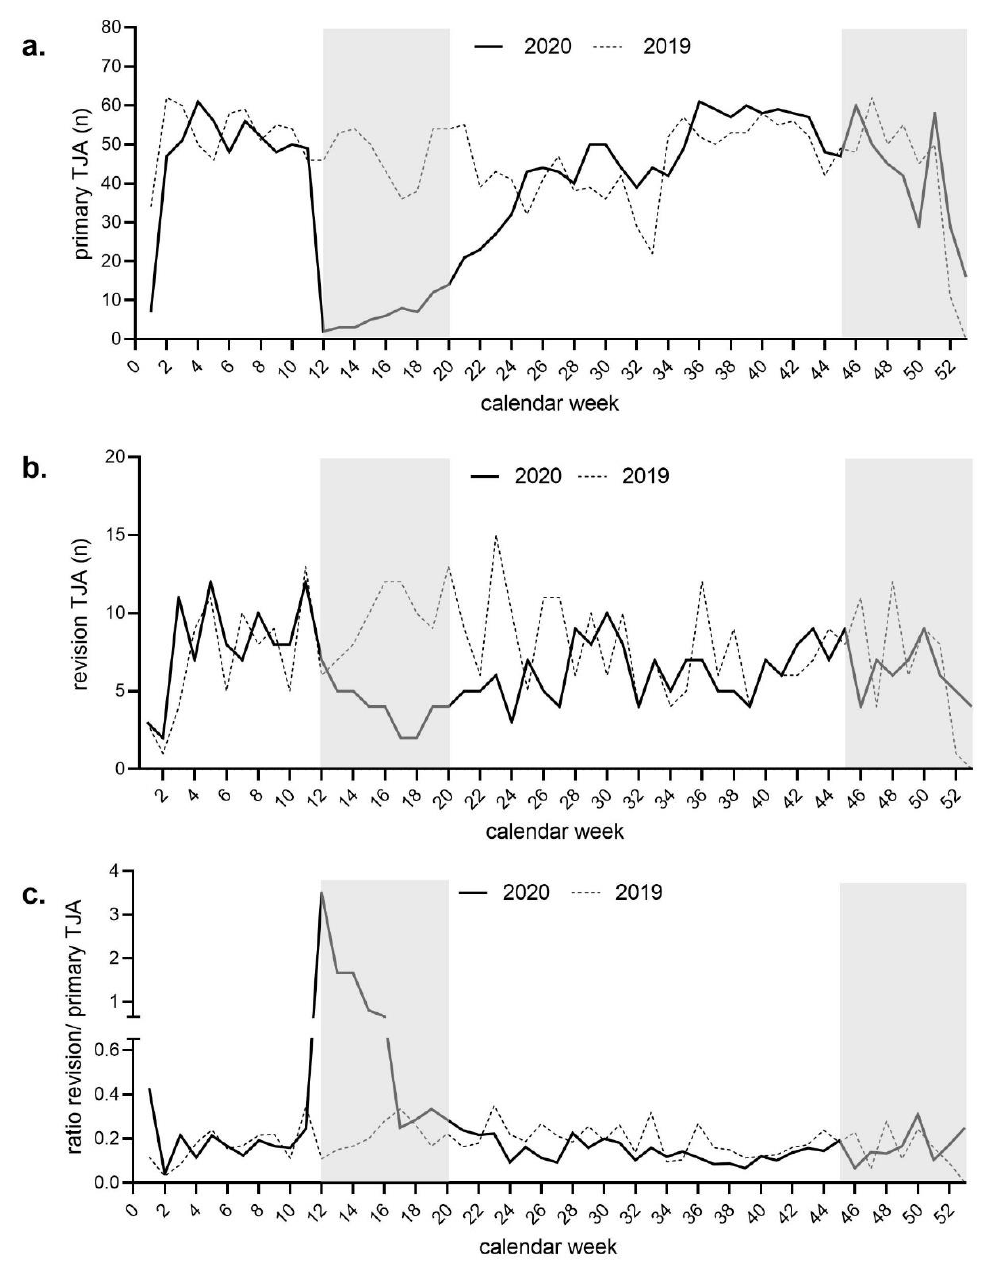
Figure 3. Number of performed primary and revision total joint arthroplasties. ( a ): Absolute numbers of primary TJAs per calendar week, comparing 2019 and 2020. The grey shaded areas visualize the first and the second wave in Austria. ( b ): Absolute numbers of primary TJAs per calendar week, comparing 2019 and 2020. The grey shaded areas visualize the first and the second wave in Austria. ( c ): Ratio between the numbers of revision and primary TJAs per calendar week, comparing 2019 and 2020. The grey shaded areas visualize the first and the second wave in Austria.